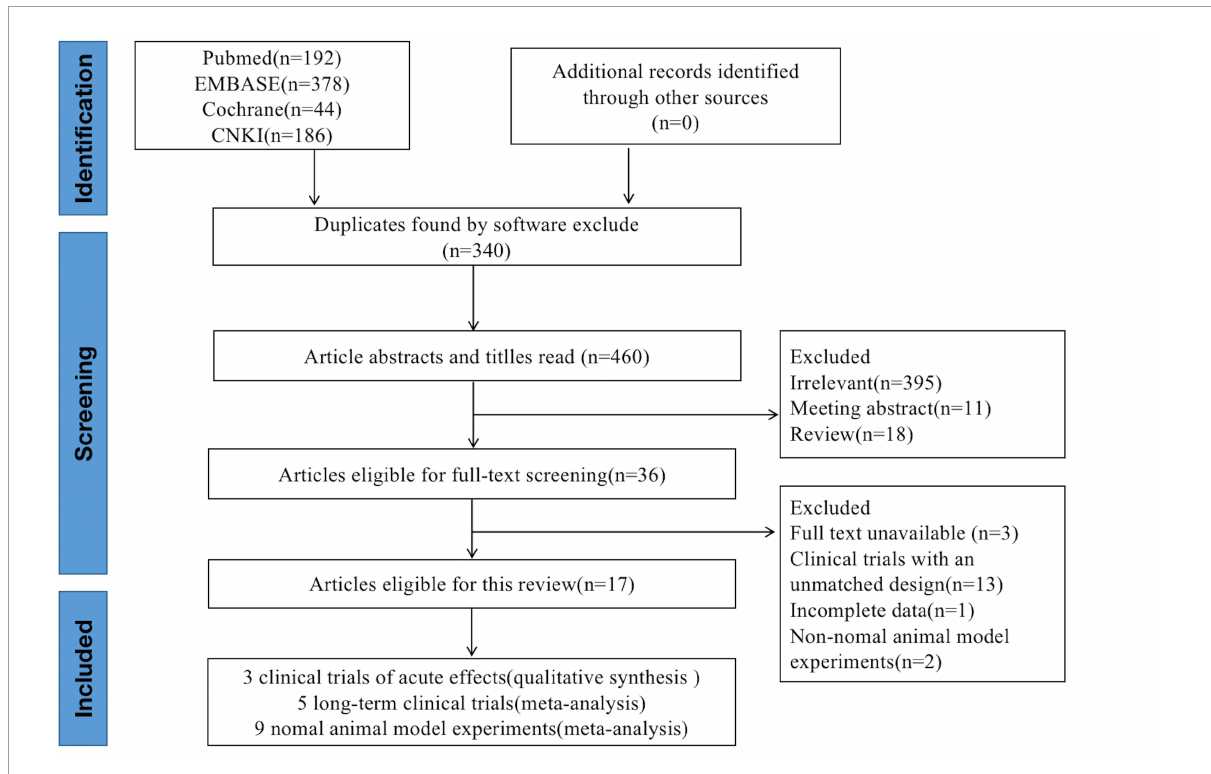
FIGURE1 Literature selection process for the present systematic review and meta-analysis.